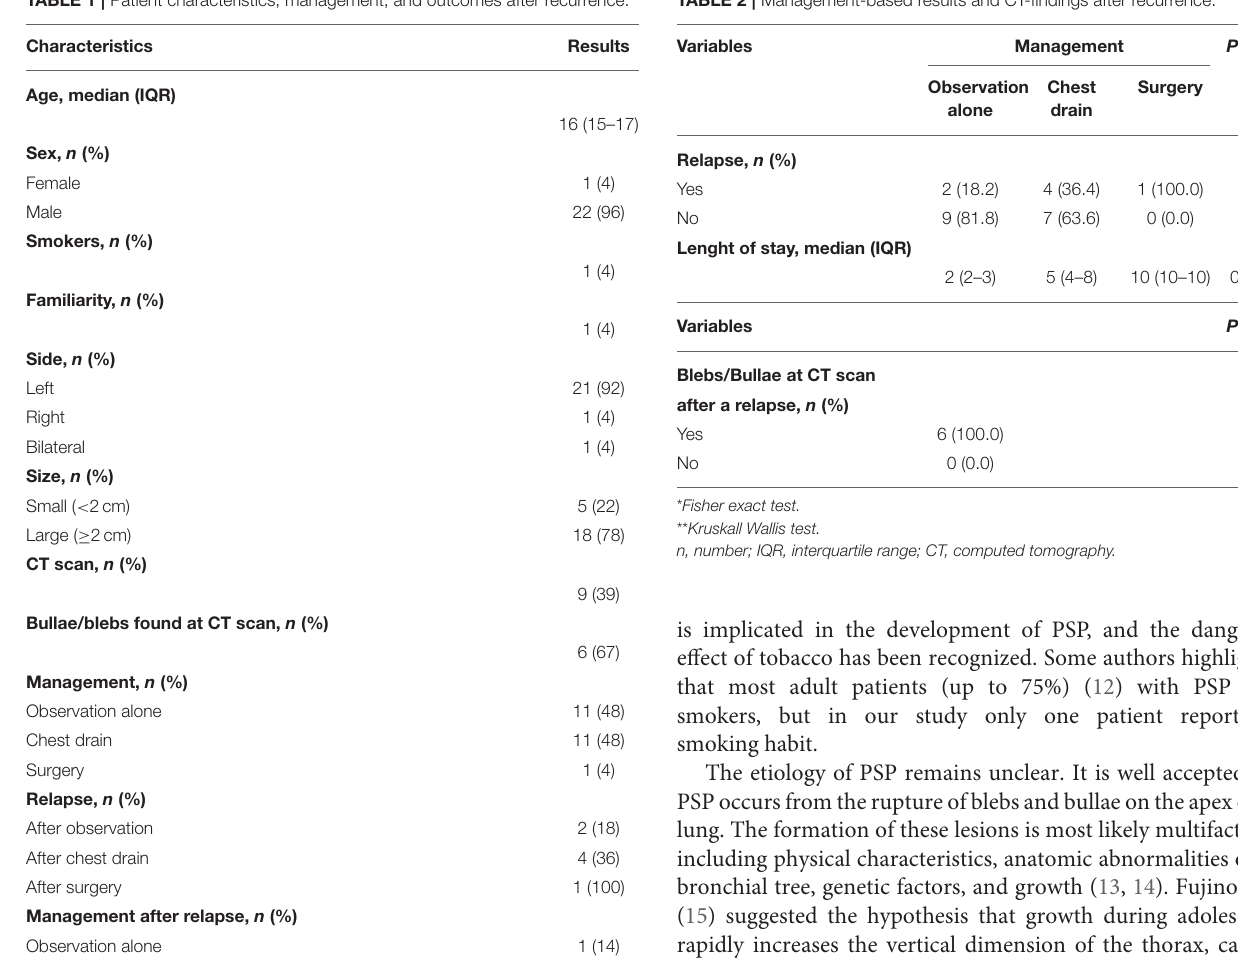
TABLE 1 | Patient characteristics, management, and outcomes after recurrence. TABLE 2 | Management-based results and CT-findings after